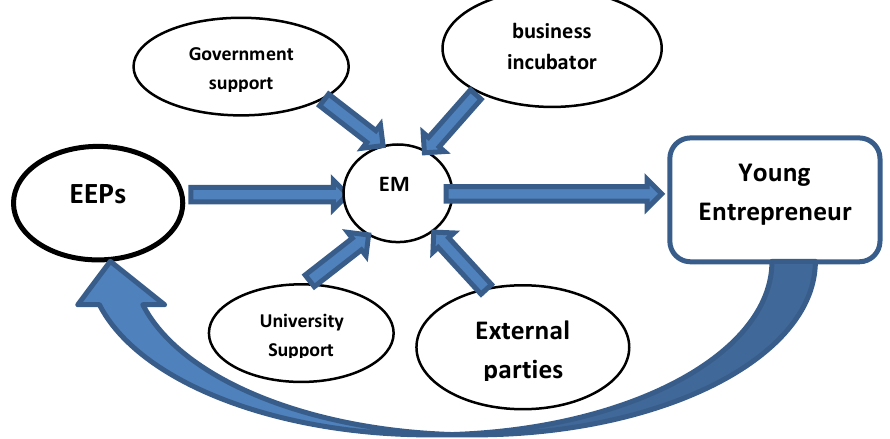
Figure 1: Cooperation scheme between the Government, Universities, external parties, and business incubator facilities in developing EEPs for the formation of EM and subsequently creating young Indonesian